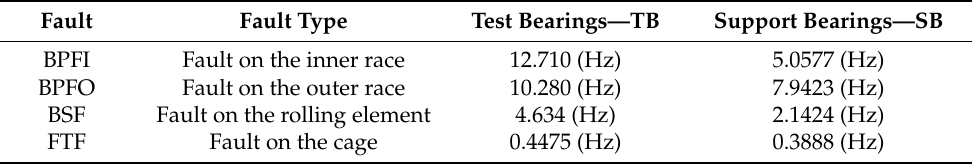
Table 1. Fault characteristic frequencies of test and support bearings at 1371 rpm (rated rotational speed).